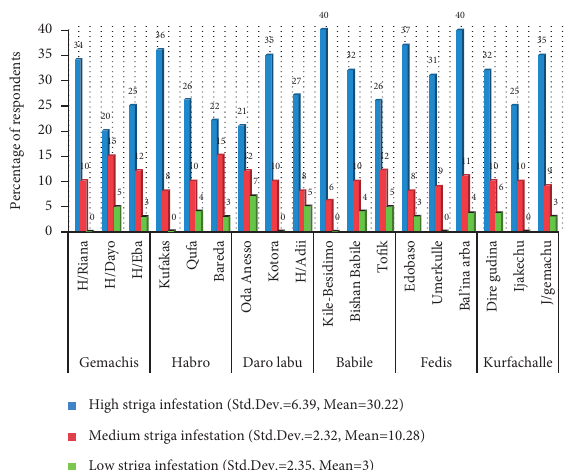
Figure 3: Farmers’ responses on the dispersal rate of Striga hermonthica in surveyed districts. Table 4: Farmers’ responses to the soil status and season in which Striga infestation was worst during the 2019 cropping season.